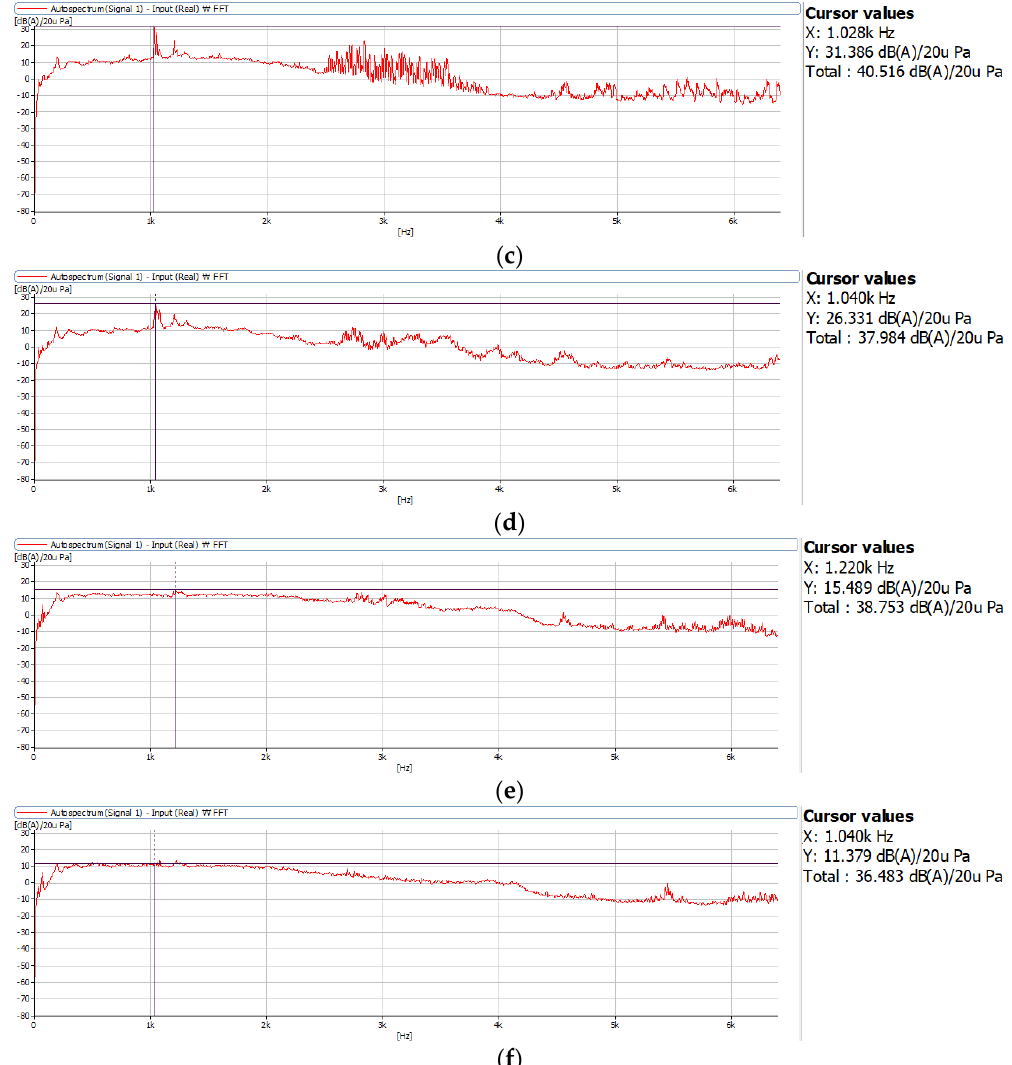
Figure 24. Experimental result of noise test between the base and proposed models: ( a ) base model (front); ( b ) proposed model (front); ( c ) base model (rear); ( d ) proposed model (rear); ( e ) base model (side); ( f ) proposed model (side).